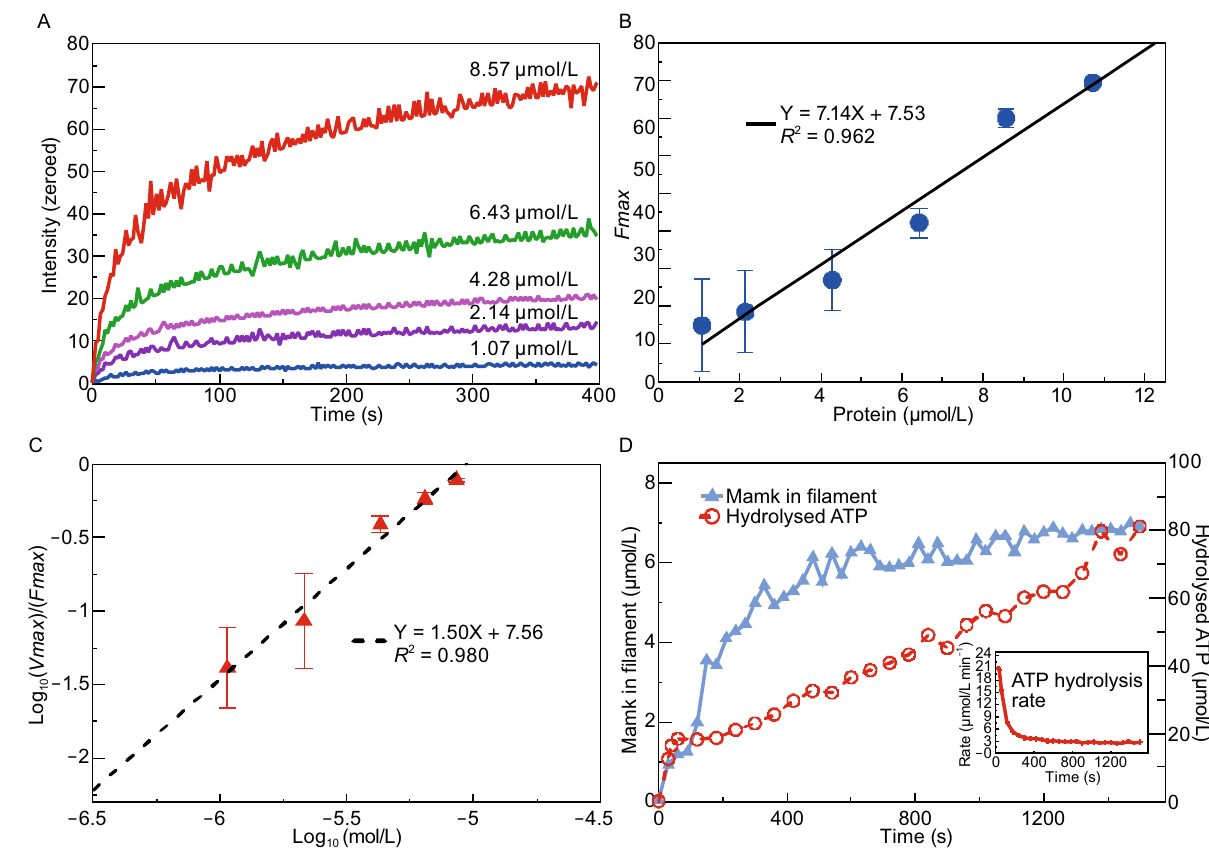
Figure 6. Polymerization kinetics of MamK. (A) Assembly kinetics of MamK at varying concentrations under standard conditions. (B) Determination of the critical concentration, which was determined as the x-intercept after plotting the maximum intensity values versus the protein concentration in (A). (C) Determination of the nucleus size and relative nucleation rates. The logarithm of the maximum polymerization rate is plotted versus the logarithm of the protein concentration in (A). The nucleus size ( n ) was estimated as two times the slope of the linear fi t. The relative nucleation rate ( Kn ) was determined as the x-intercept in the plot. (D) Steady ATP hydrolysis during MamK polymerization. MamK in the fi laments was determined as the total protein concentration minus the monomer concentration by the Bradford method after the monomers and fi laments were separated. ATP hydrolysis was measured as the amount of phosphate released at various time points, and the inset shows the ATP hydrolysis rate (µmol/L·min − 1 of Pi) de fi ned as the amount of released phosphate per